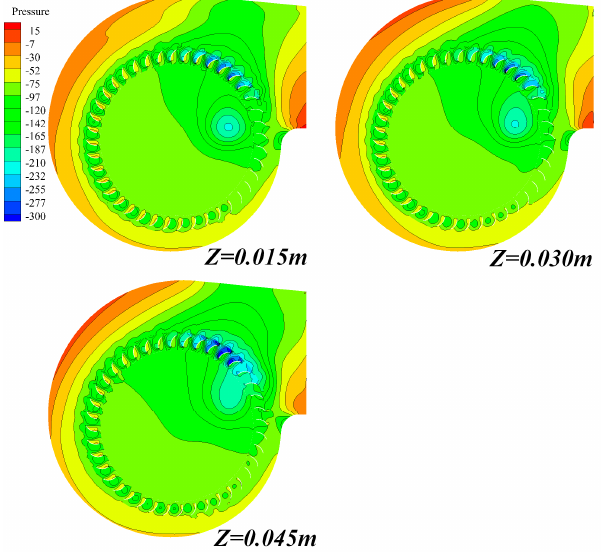
Figure 14. Static pressure of cross-sections at different positions (Q/Qn = 1.758).